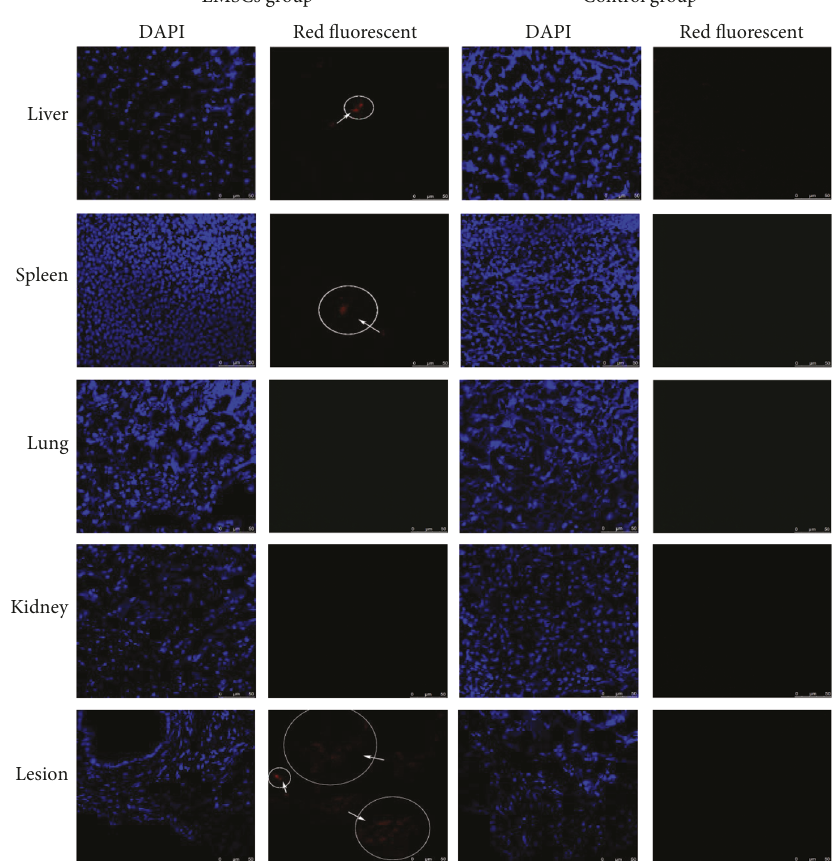
Figure 4: Tropism of EMSCs to endometriosis in vivo. Confocal laser scanning microscopy was used to detect red fl uorescence in liver, spleen, lung, kidney, and lesion tissue samples from both groups. The ampli fi ed view of EMSCs migrated to liver, spleen, and endometriotic lesion were shown as circles with